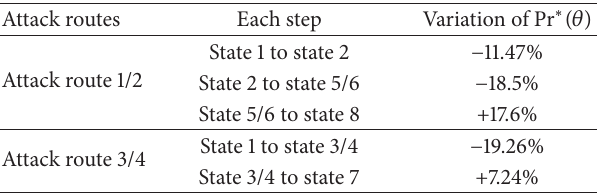
Table 4: Variation of Pr ∗ (𝜃) in each step of all attack routes. Attack routes Each